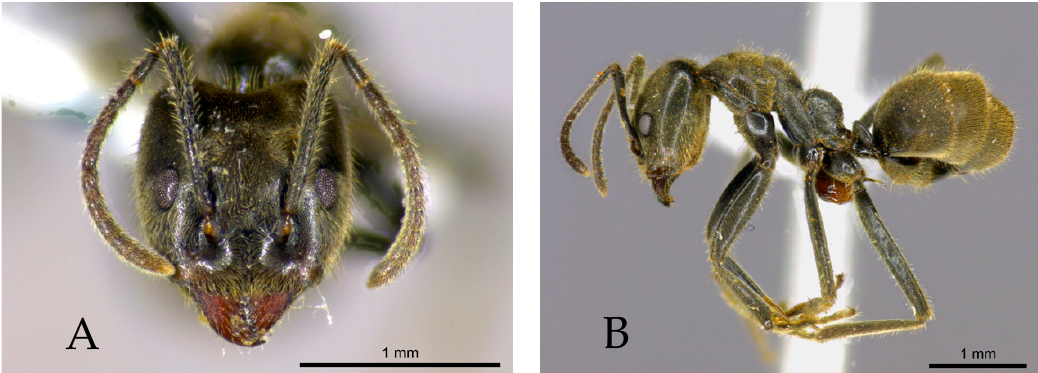
Figure 1. Anonychomyrma gilberti , showing head ( A ) and lateral ( B ) views.